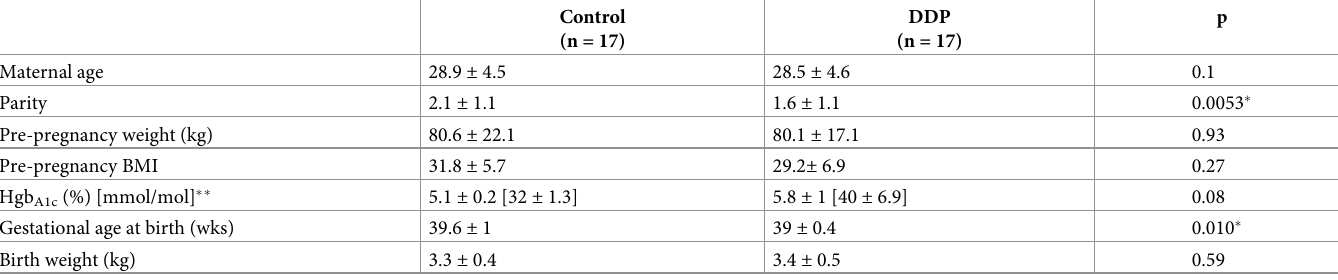
Table 1. Maternal and infant